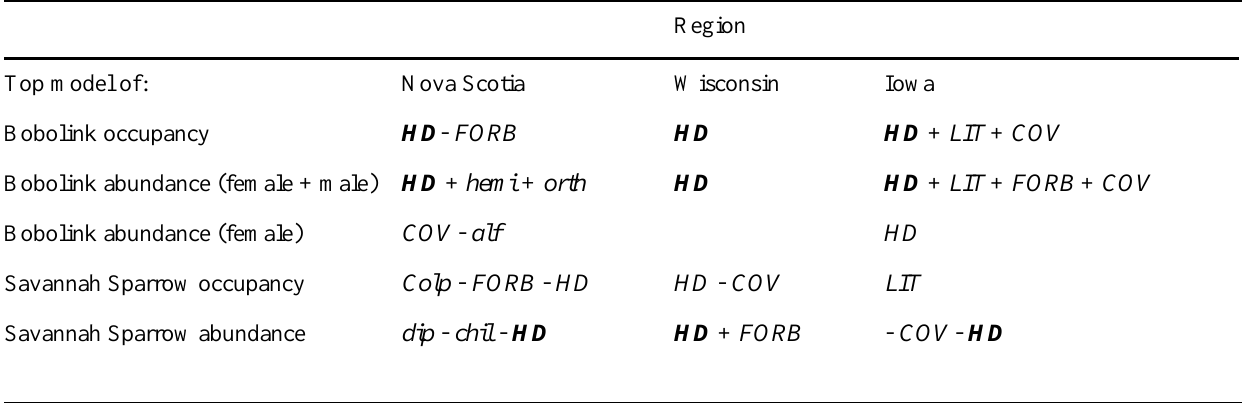
Table 4. Top models of vegetative correlates (notation as per Table 1) for presence/absence, i.e., occupancy, and abundance of Bobolinks and Savannah Sparrows from three different regions, habitat types, and studies: Nova Scotia, i.e., hayfields, this study, Wisconsin (pastures; Renfrew 2002), and Iowa (prairies and restored grasslands; Fletcher 2003). Only combined-sex Bobolink data were available for Wisconsin. Lower-case letters represent variables important to Nova Scotia models not sampled in Wisconsin or Iowa. Logistic mixed-effects models were created to model occurrence, and linear mixed-effects models for abundance. Variables in bold are shared in top models for all study